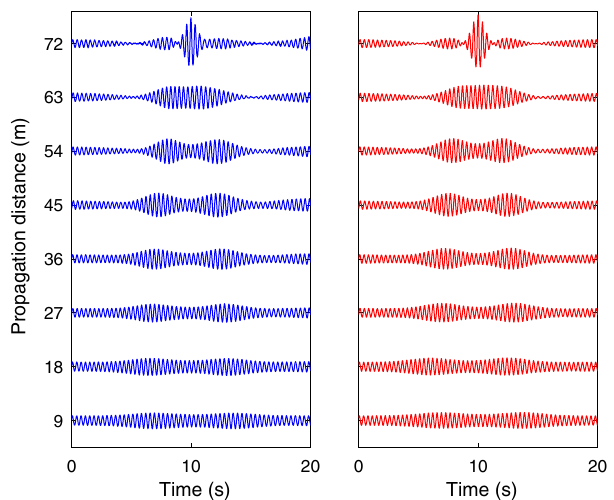
FIG. 3. Wave-profile evolution in the experiment with split propagation. The left panel shows experimental profiles at the end of each segment, while the right panel shows theoretical ones. Up to a distance of 63 m, the curves are almost identical. The maximum amplitude of the higher-order breather is reached at the end of the total propagation distance of 72 m.